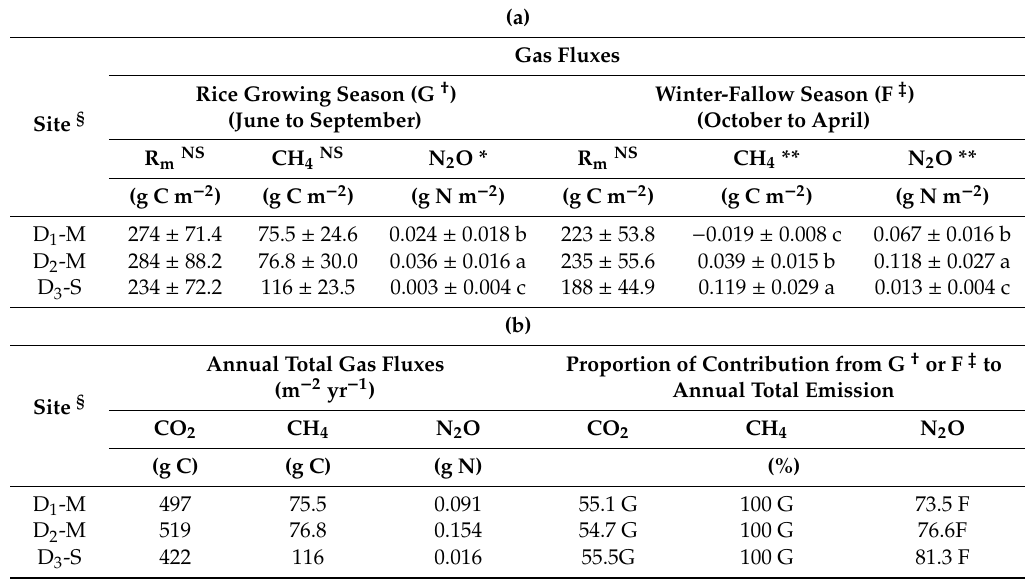
Table 3. Seasonal greenhouse gas fluxes and their contribution to total annual gas fluxes from paddy-fallow cropping systems. ( a ) Seasonal greenhouse gas fluxes from paddy-fallow cropping systems. ( b ) Total annual gas fluxes from paddy-fallow cropping systems and proportion of contribution from rice growing or winter-fallow season to annual total emission.